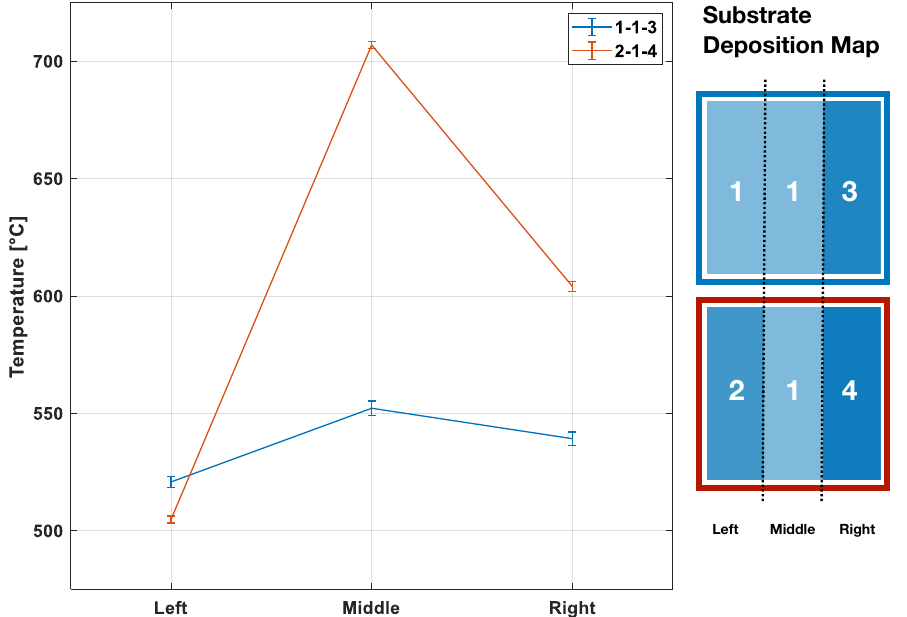
Figure 7. Comparison of two substrates with tailored catalyst distribution. T substrate is compared within three regions coated with 1, 2, 3, and 4 sides coated. The substrate map on the right provides the number of coats received by the two tailored substrates, i.e., 113 and 214. A single thermocouple was placed in the center of each region at a distance of 6.5 mm from each other with the center thermocouple directly in the middle of the substrate. Air flow rate of 6000 mL/min was maintained. Considering both the substrates were exposed to the same flow conditions, the middle third should exhibit identical temperatures. This was not the case, since the middle